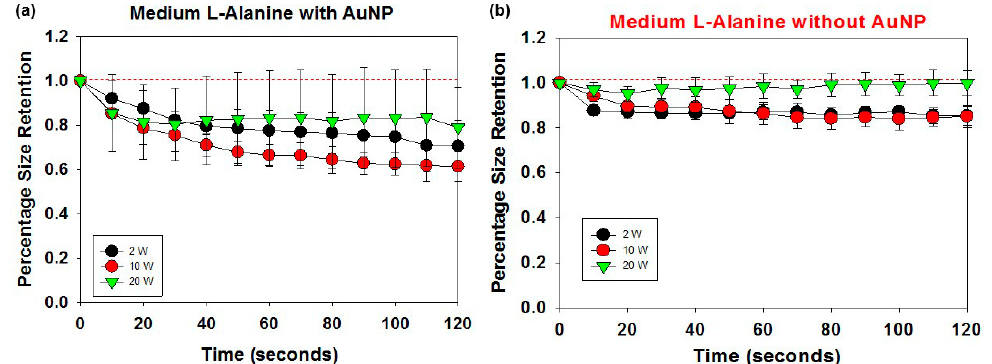
Figure 3. Normalized size retention rate of medium-sized L -alanine crystals (initial size = 300 μ m) after 120 s of microwave heating ( a ) in the presence of gold nanoparticles and ( b ) in the absence of gold nanoparticles (control).